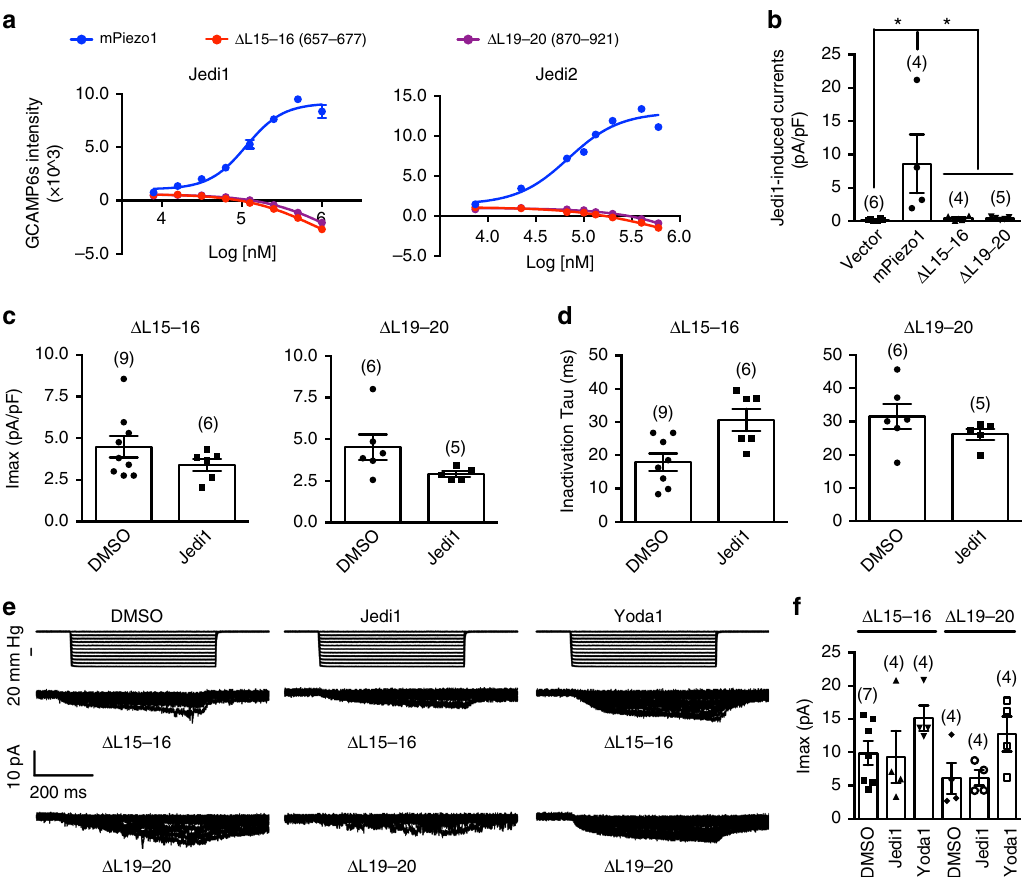
Fig. 5 L15-16 and L19-20 are essential for Jedi activation of Piezo1. a Dose response curves of HEK293T cells transfected with GCAMP6s and the indicated constructs in response to the speci fi ed compounds as assayed by FLIPR. The curves were fi tted with a Boltzmann equation. Each data point represents mean ± s.e.m., n = 4 wells. b Scatter plot of the chemical-induced currents from Piezo1-KO-HEK cells transfected with the indicated constructs. Statistical signi fi cance was assessed using one-way ANOVA with multiple comparison. c Scatter plot of the poking-induced Imax. Statistical signi fi cance was assessed using unpaired, two-tailed Student ’ s t -test. d Scatter plot of the inactivation tau of the poking-induced currents. Statistical signi fi cance was assessed using unpaired, two-tailed Student ’ s t -test. e Representative stretching-activated currents of cells recorded at − 80 mV. f Scatter plot of the maximal stretching-activated currents. Statistical signi fi cance was assessed using one-way ANOVA with Dunn ’ s comparison to the DMSO-treated group. Each bar represents mean ± s.e.m., and the recorded cell number is labeled above the bar. * P <